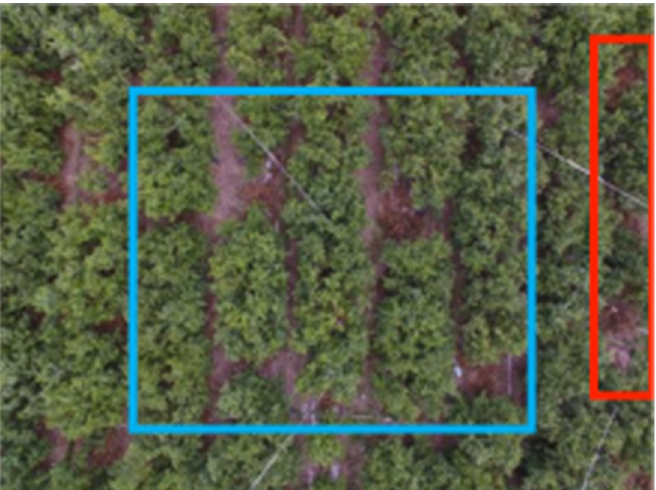
Figure 11. Vertical view of a citrus orchard from a drone. The blue square shows the area where the UAV can vertically observe the ground. The red box shows the problem of canopy occlusion.